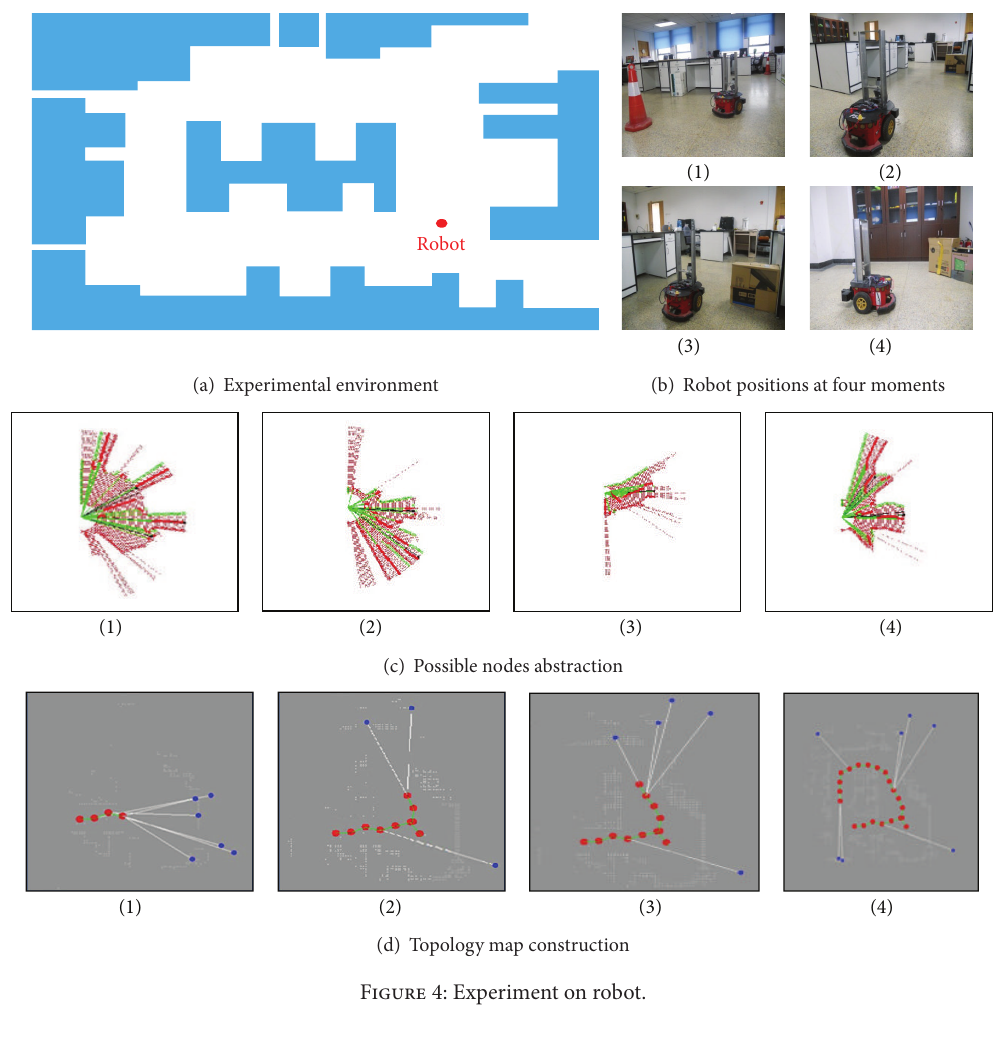
Figure 4: Experiment on robot.